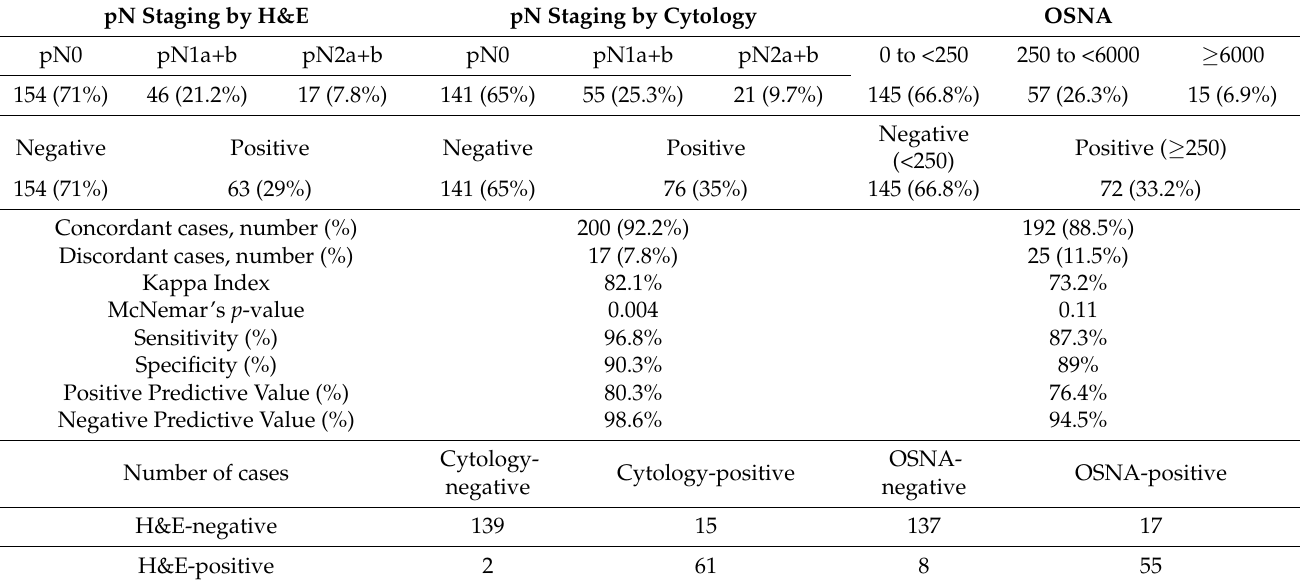
Table 3. Concordance in the pN staging among techniques and diagnostic